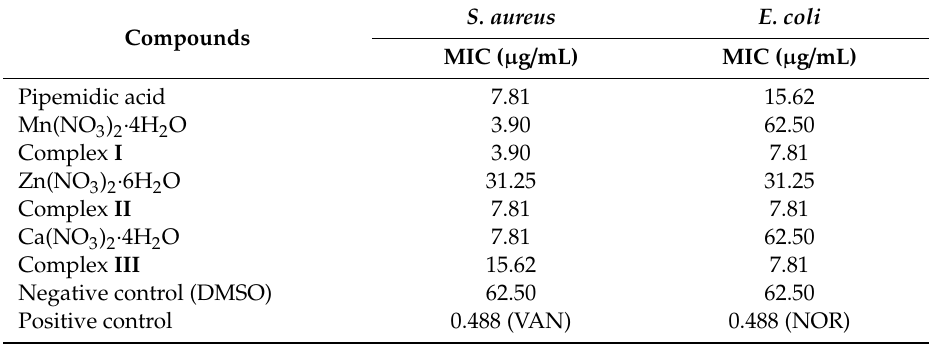
Table 2. Minimum inhibitory concentration (MIC) of each reagent and complexes I , II and III for Escherichia coli (Gram-negative) and Staphylococcus aureus (Gram-positive). The concentrations tested ranged from 500 to 0.061 µ g / mL.